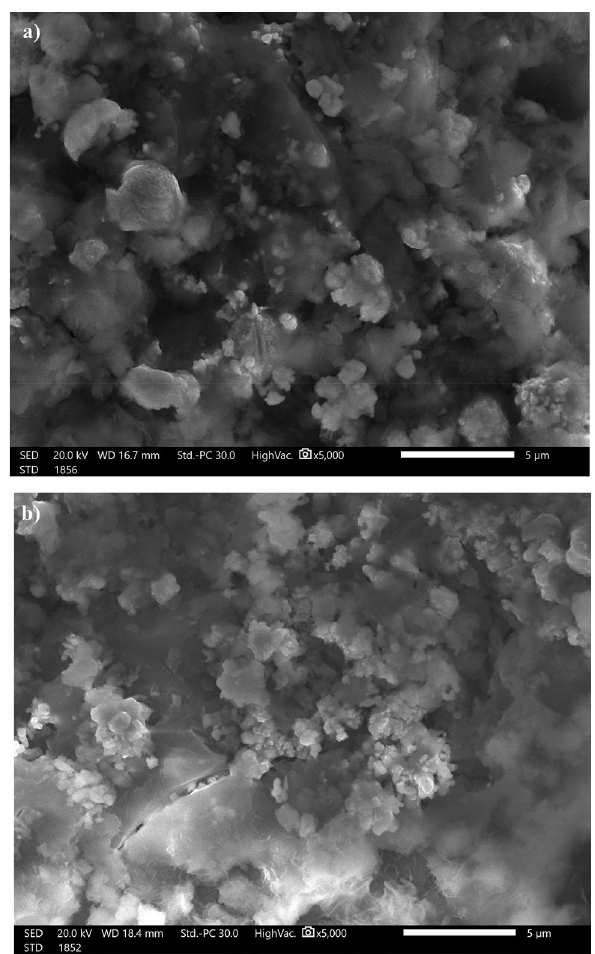
Figure 7. SEM images of steel coated by ( a ) Ni-SA coating and ( b ) Ni-G-SA coating after abrasion test.